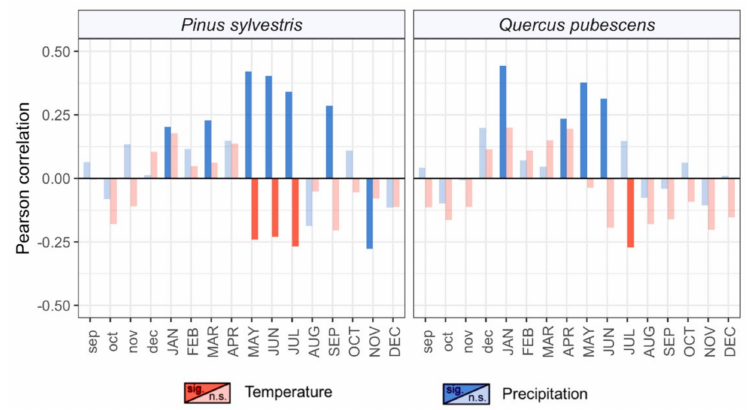
Figure 6. Pearson’s correlation coefficients between tree-ring width chronologies of Scots pine and pubescent oak and monthly mean temperature and total sum of precipitation for the period 1950–2014. Significance at p < 0.05